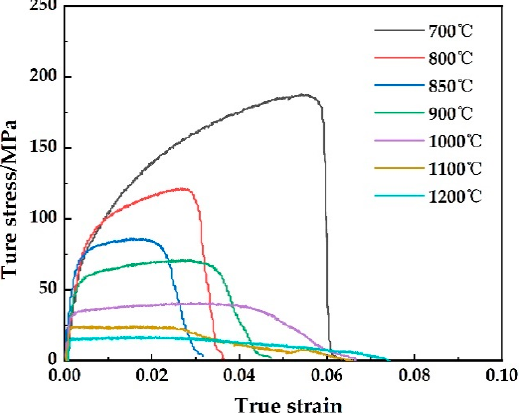
Figure 4. Stress-strain of 304-Cu at different temperatures.